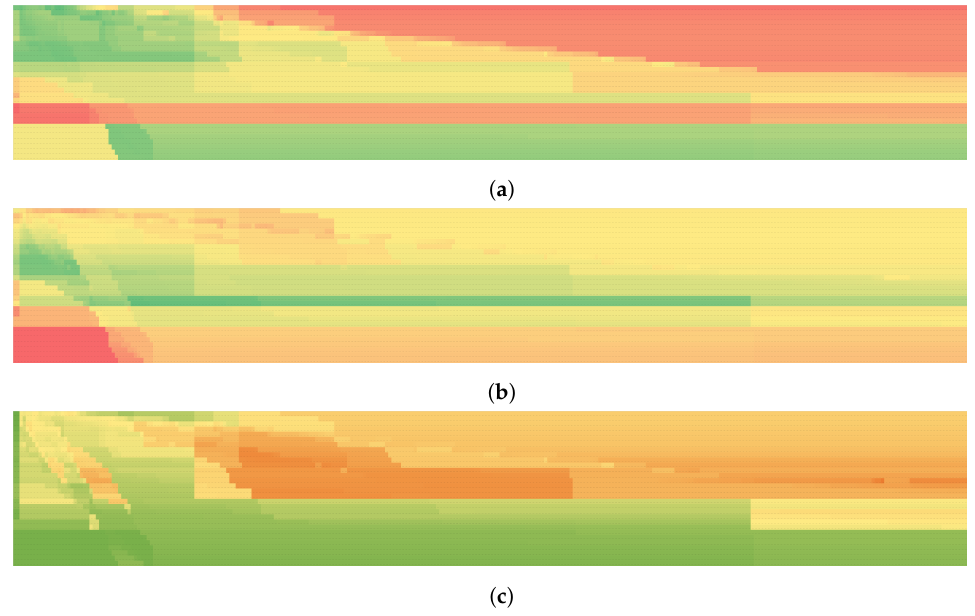
Figure 5. Heatmaps produced for the evaluation metrics of each experiment run. ( a ) Silhouette coefficient. ( b ) Calinski–Harabasz score. ( c ) Davies–Bouldin